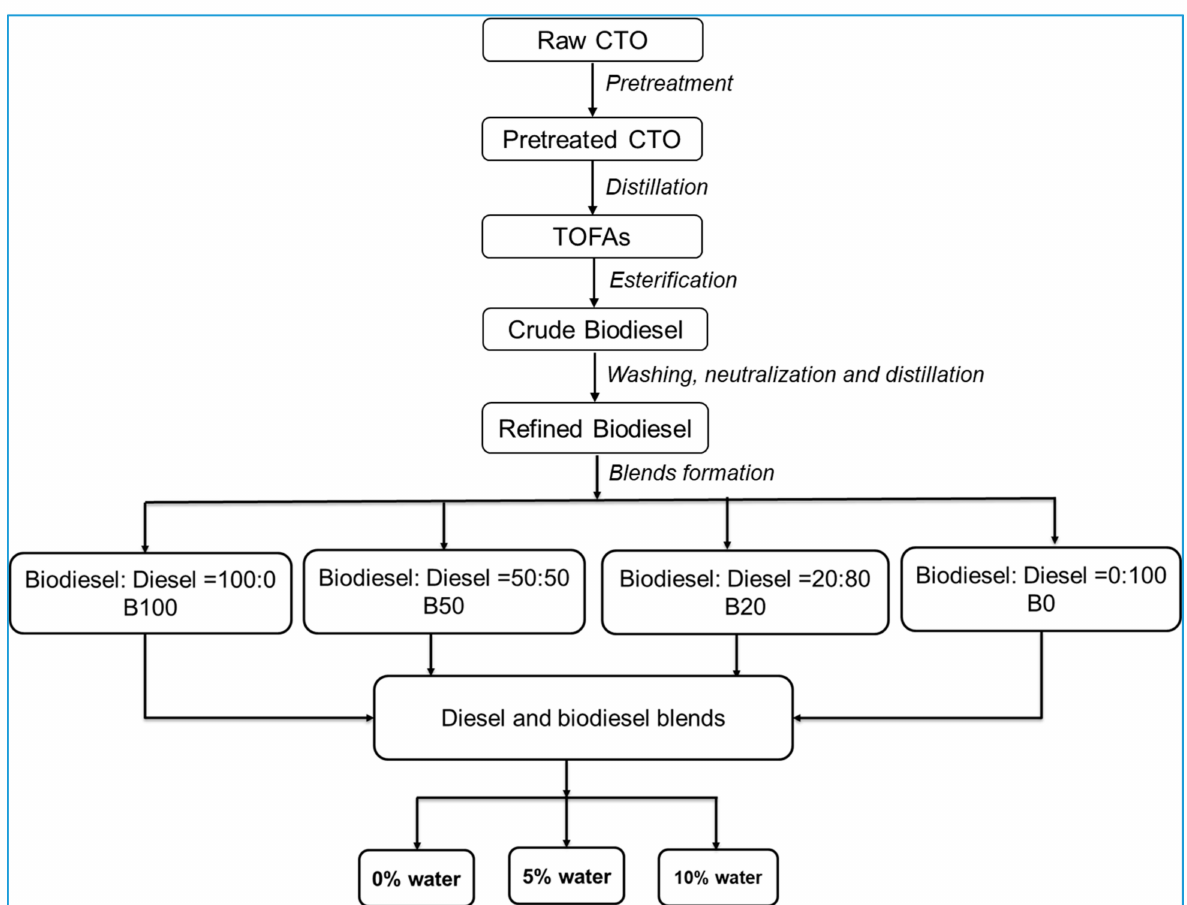
Figure 1. Flowchart of biodiesel production from raw crude tall oil (CTO) and their blends with